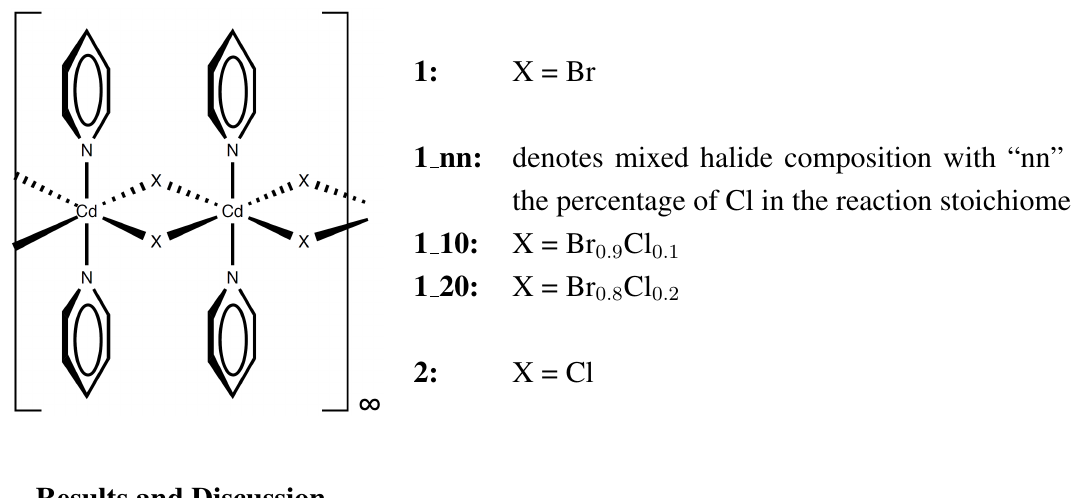
Scheme 1. Structural formula of [ { Cd( µ -Br) extension of the polymer chain (left) and naming convention